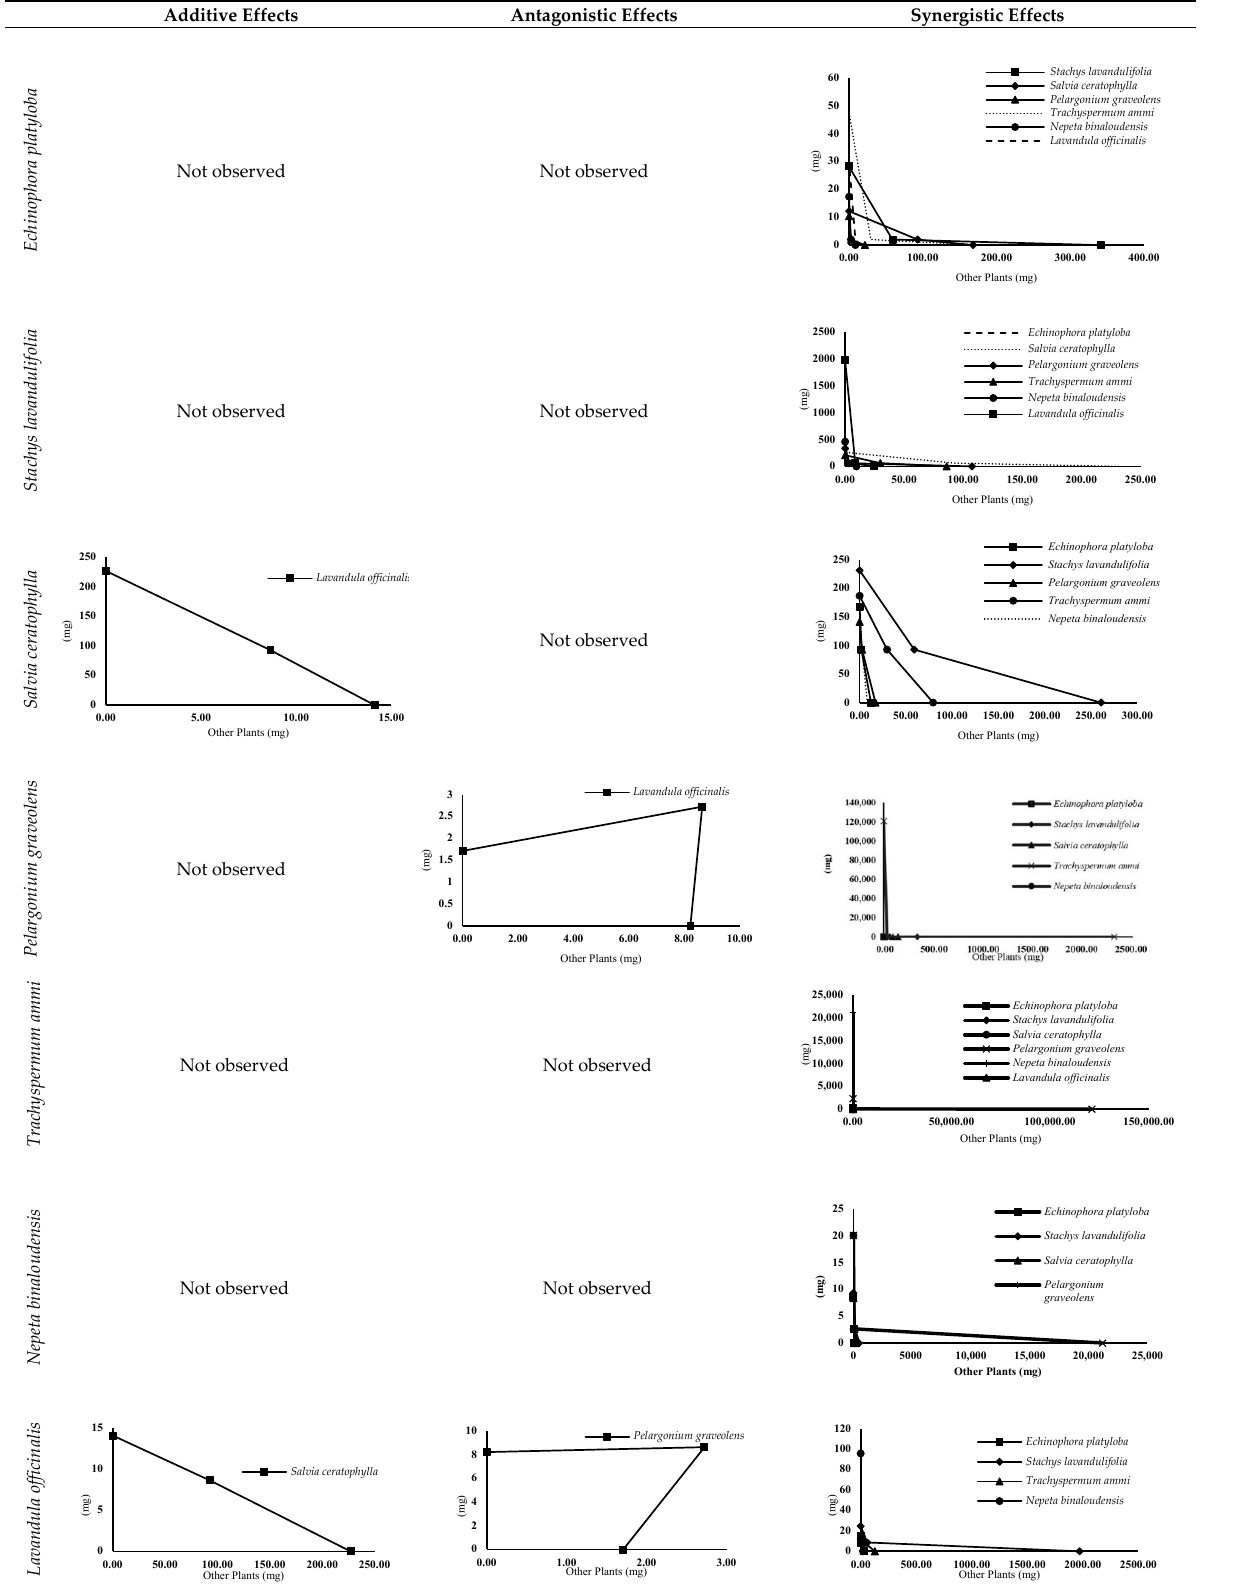
Figure 6. Isobologram curves of allelopathic interaction effects of plants on lettuce radicle growth inhibition.